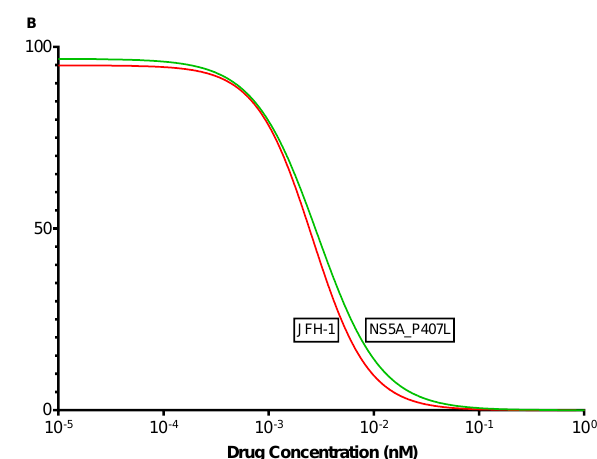
Figure 3. IC50 drug response curves shown for SGR constructs. The constructs harbouring NS5A_R353K is shown in panel ( A ) and NS5A_P407L in panel ( B ).